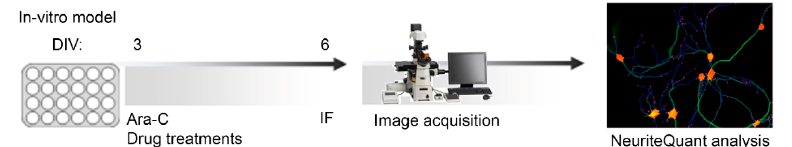
Figure 7. Workflow for phenotypic screening. Primary hippocampal neurons were plated at DIV 0 in 96 multi-well, and at DIV 3 were added D-Arabinofuranoside (ARA-C, Sigma) and treatments with extracts or bioactive molecules. Neurons were fixed in PFA 4% at DIV 6 and immunofluorescence (IF) was performed with anti-MAP2 (red), and anti-NeuN (green). Images were acquired using Nikon Eclipse Ti-E epifluorescence live imaging microscope equipped with Nikon DS-Qi2 camera, using 10x objective. Eleven random fields (3.0 × 3.0) per well were acquired and analyzed individually. Total Dendritic Length (TDL) and the number of Endpoints per neuron (EP) were measured with NeuriteQuant software, implemented as a plugin of ImageJ [58].